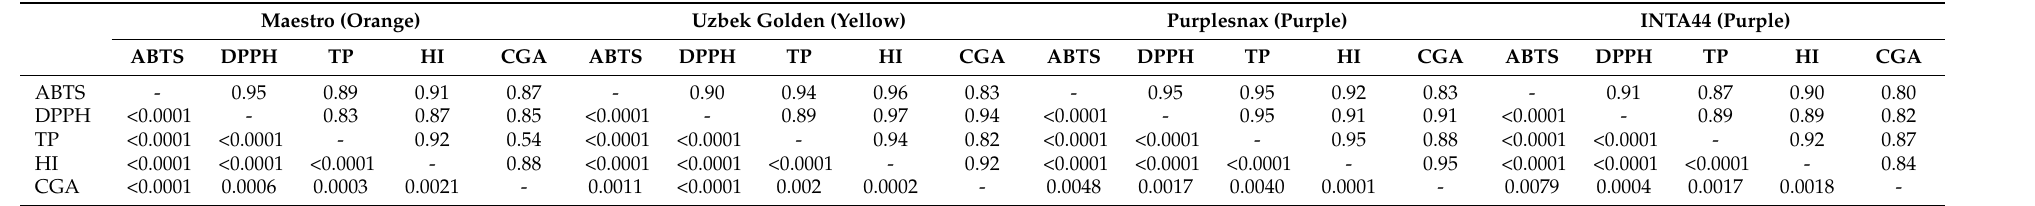
Table 1. Pearson correlation coefficient (r) and p values among root concentration of different phenolics and antioxidant capacity estimates for four carrot cultivars with different root color